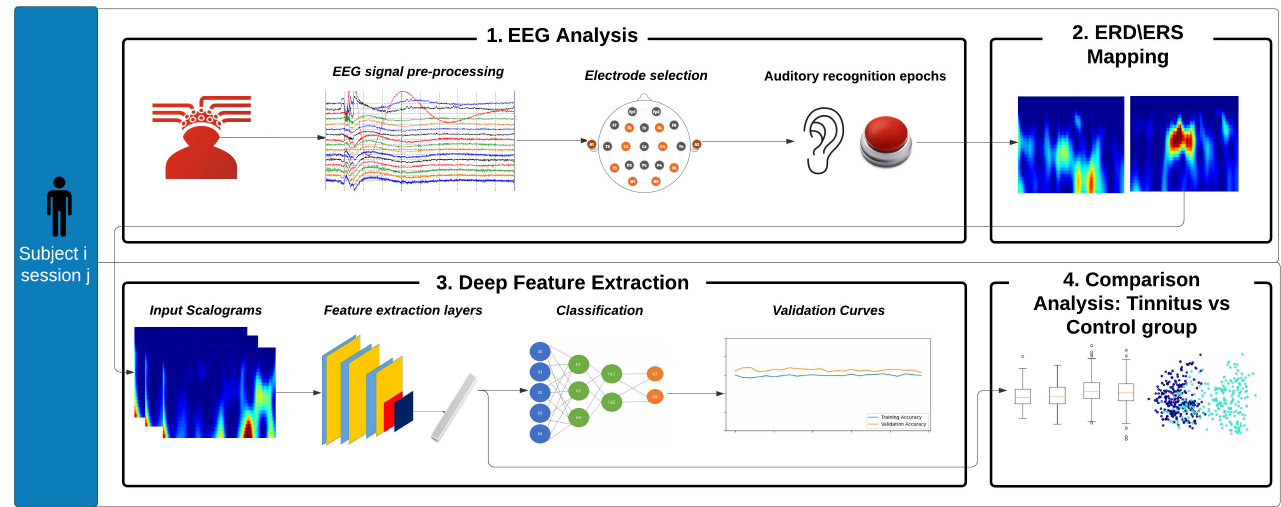
Figure 1. Four-step based methodology followed for the current research study: (1) EEG Analysis, (2) ERD/ERS Mapping, (3) Deep Feature Extraction, and (4) Comparison Analysis: Tinnitus vs. Control